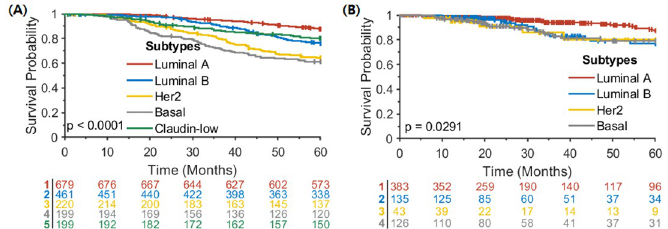
Fig 7. Kaplan-Meier analysis for intrinsic molecular subtypes in (A) METABRIC and (B) TCGA breast cancer studies with no normal-like samples.